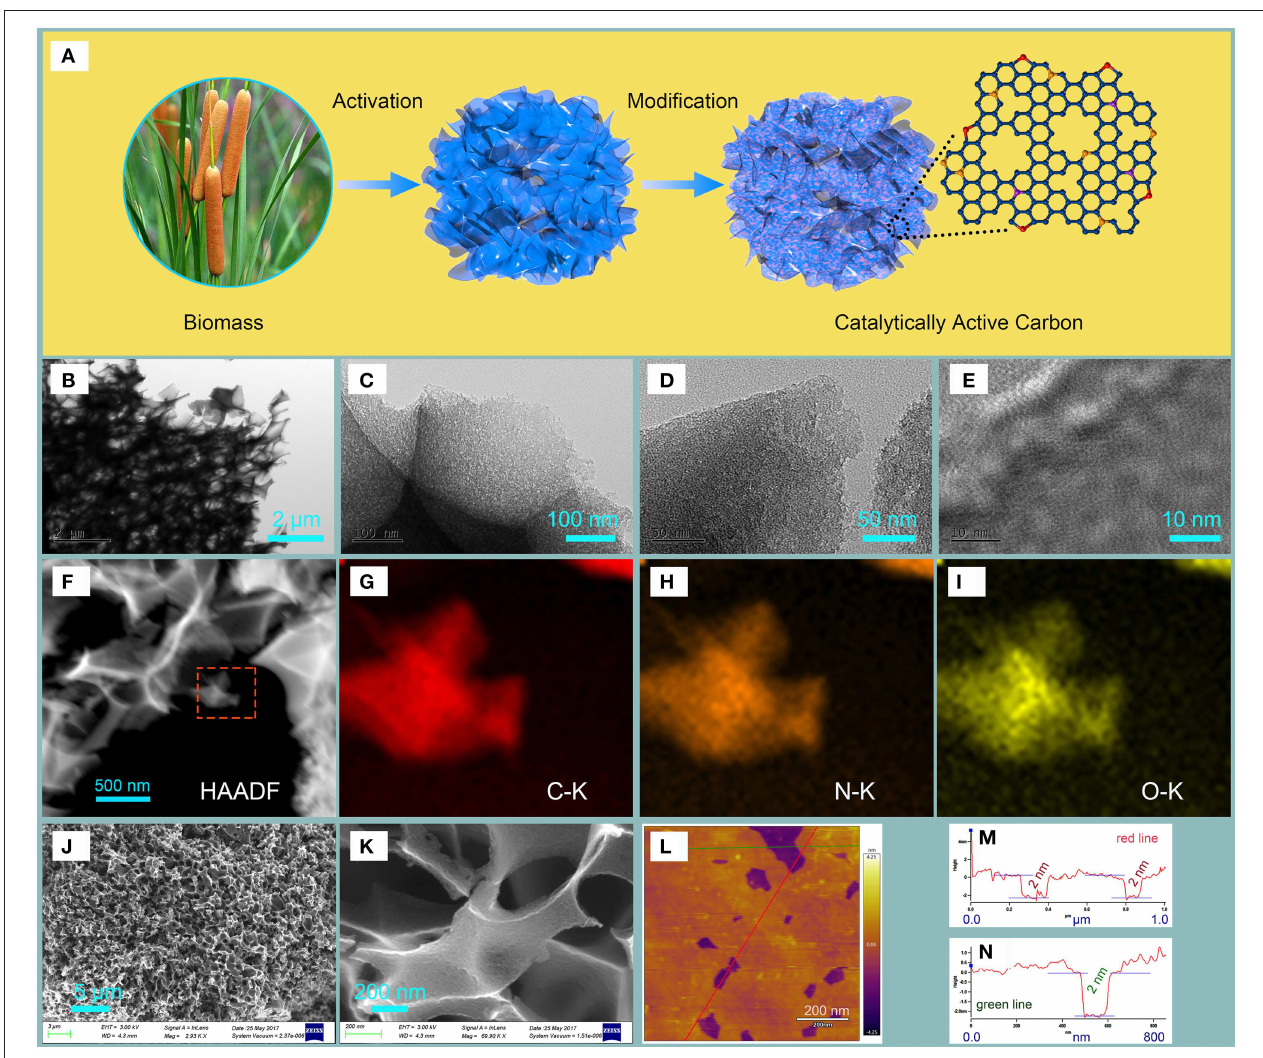
FIGURE 1 | The (A) Preparation of NHPCF from cattail spikes, (B–E) TEM images, (F) HAADF images, (G–I) EDX elemental mapping images of NHPCF, (J,K) SEM image, (L) AFM image, and (M,N) the corresponding height profiles of